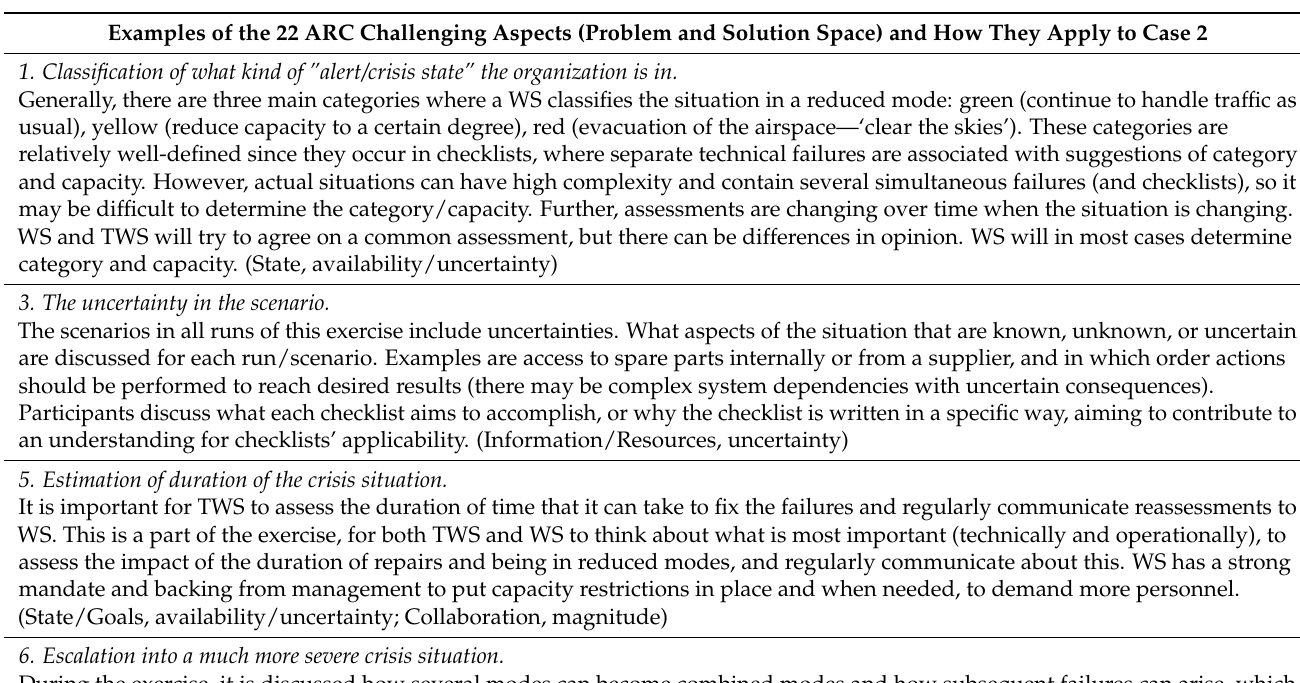
Table 6. ARC questions, and how they apply to ANSP2 reduced modes training and its